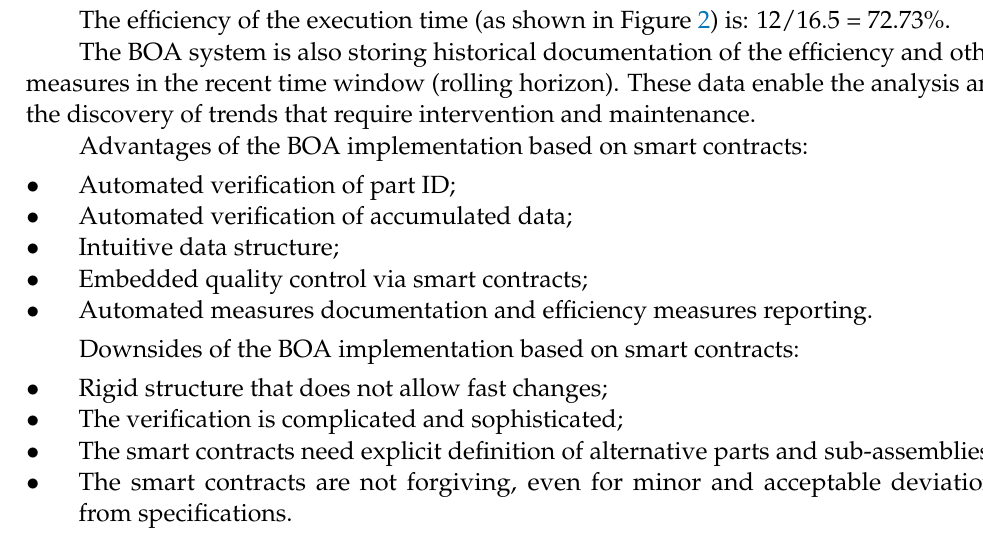
Figure 3. Illustration of the sub-assembly 1.1 efficiency computations.